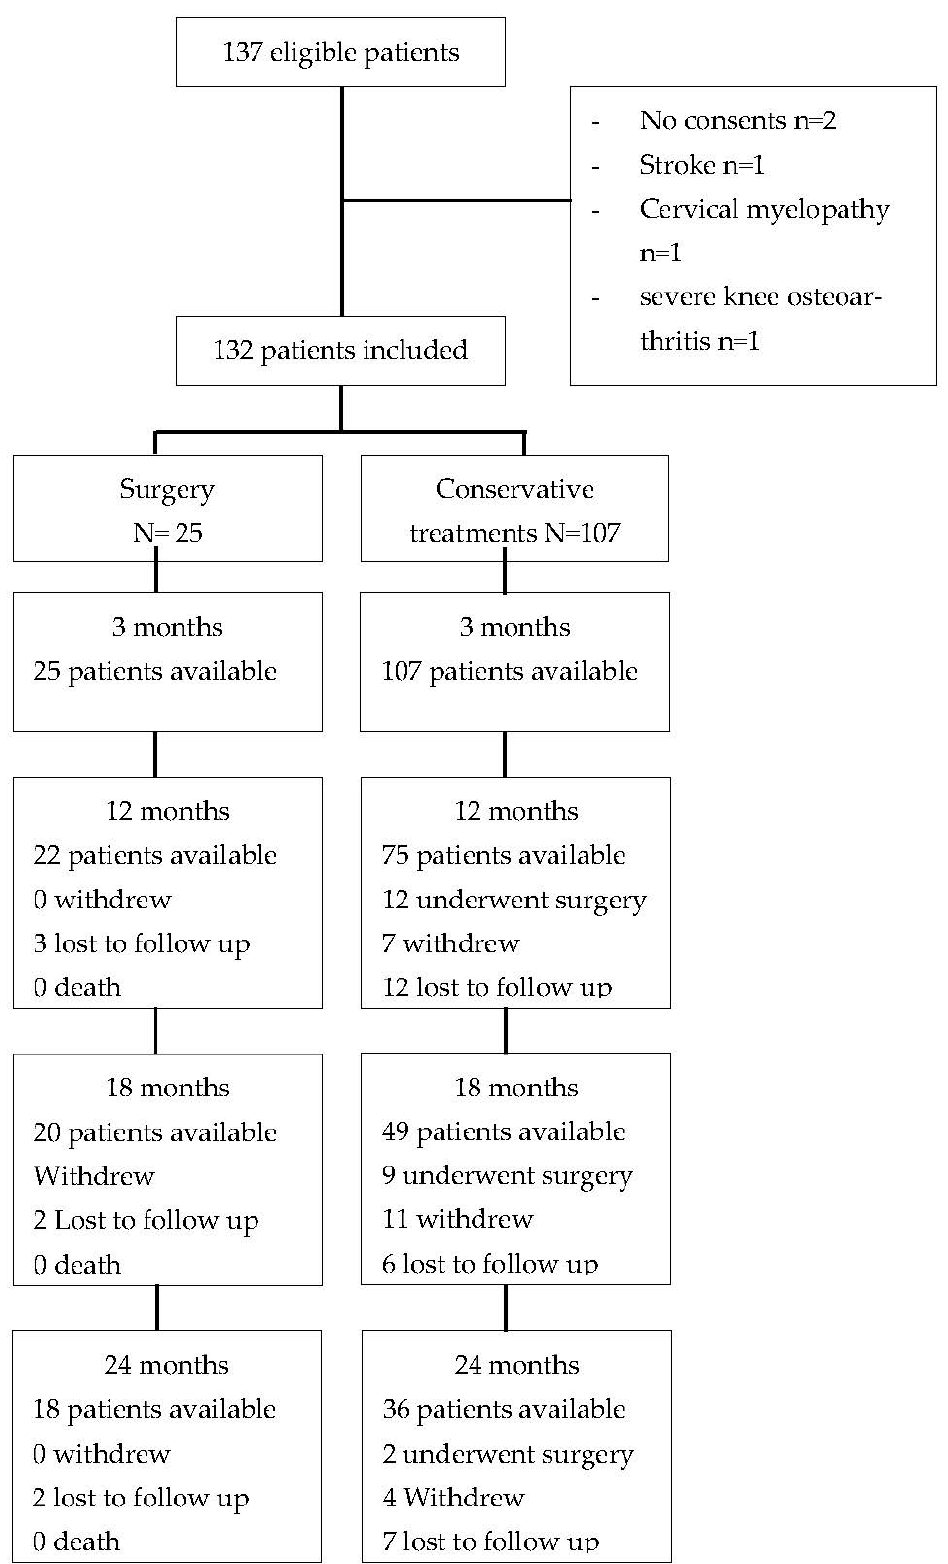
Figure 1. Flow chart of study population.